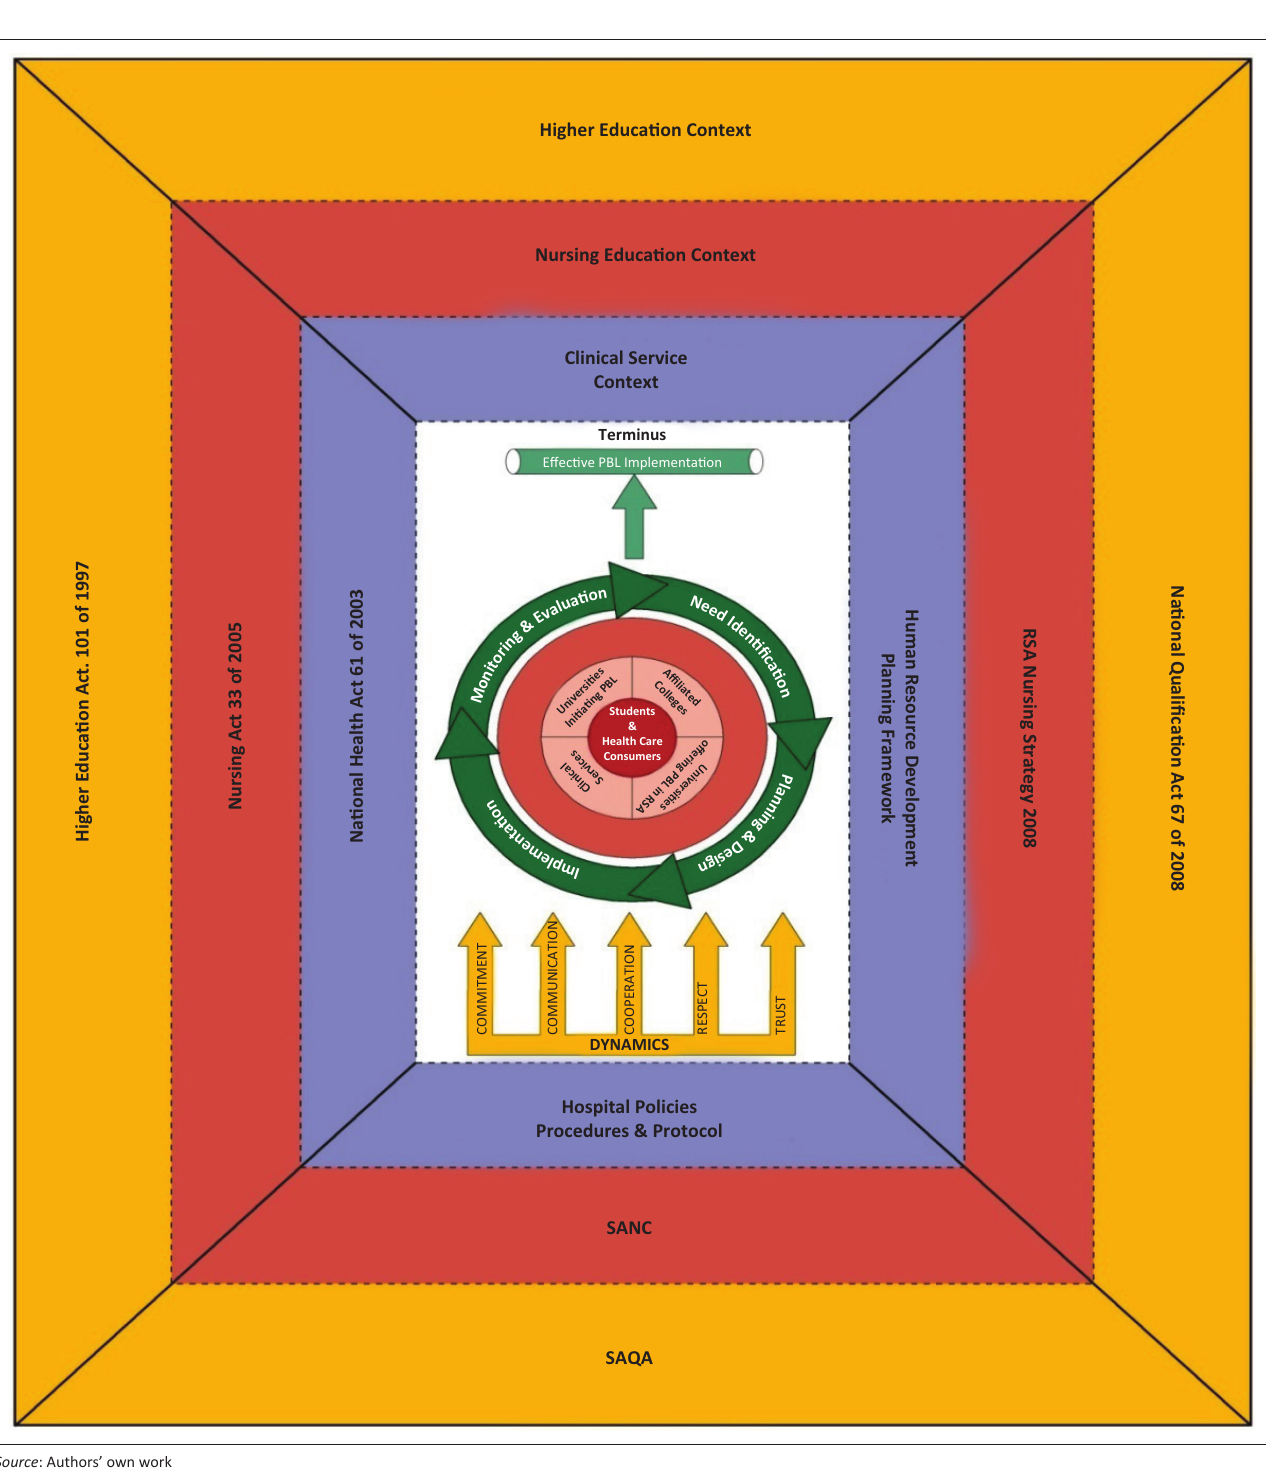
FIGURE 1: A model of collaboration in implementation of problem-based learning in nursing